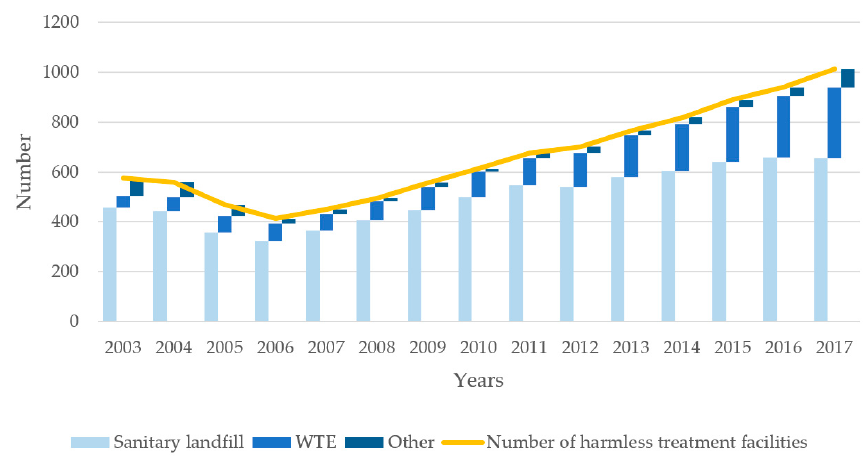
Figure 3. Number of harmless treatment facilities of MSW in China in the past 15 years.